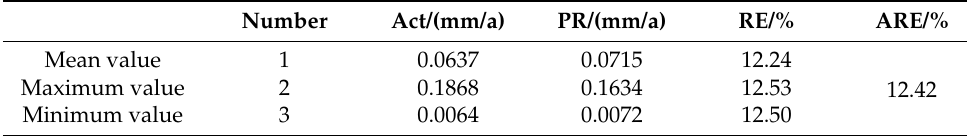
Figure 3. Comparison of measured and predicted values. 3.2. PCA Algorithm Processing Result The data in this part of the study were obtained from the simulation results of OLGA, and eight factors were selected that have a significant effect on the CO 2 corrosion rate [27]: wall shear (Pa), X1; gas phase flow rate (m/s), X2; liquid-phase flow rate (m/s), X3; liquid holdup, X4; partial pressure of CO 2 (Pa), X5; pH, X6; temperature (°C), X7; pressure (bar), X8; corrosion rate (mm/a), Y. A total of 150 sets of data were selected, and the contents are shown in Table 4.